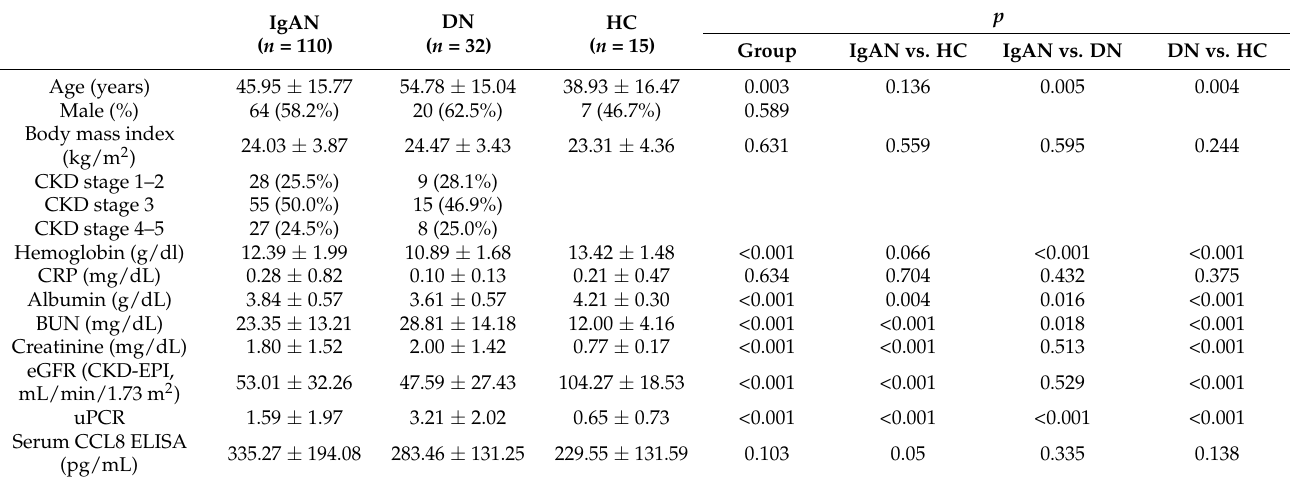
Table 1. Baseline characteristics of serum CCL8 ELISA